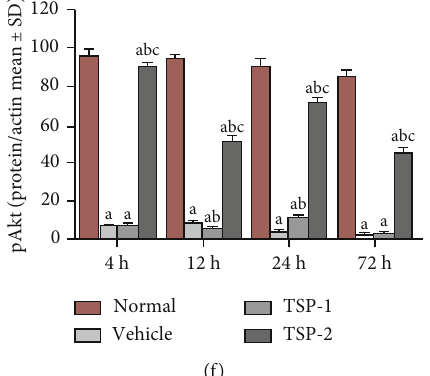
Figure 10: E ff ect of TSP overexpression on PI3K signaling in vivo . Mouse protein lysates from normal mice or mice treated with LPS for 4, 12, 24, and 72h and overexpressing either empty vector (vehicle group), TSP-1 (TSP-1 group), or TSP-2 (TSP-2 group) were analyzed for p85 (a), p-Akt, and total Akt (c) expression using Western blot analysis. β -Actin expression served as the loading control. (b, e, and f) Bar graphs are shown after normalizing the expression of p85, total Akt, and p-Akt to β -actin. (d) Bar graph for p-Akt expression is shown after normalizing to total Akt expression. The percentage of detected protein/actin is shown as mean ± SD . P value of < 0.05 represents signi fi cant di ff erence. a P < 0 : 05 compared with normal control; b P < 0 : 05 compared with vehicle group; c P < 0 : 05 compared with the TSP-1 transfected group ( n = 4 per